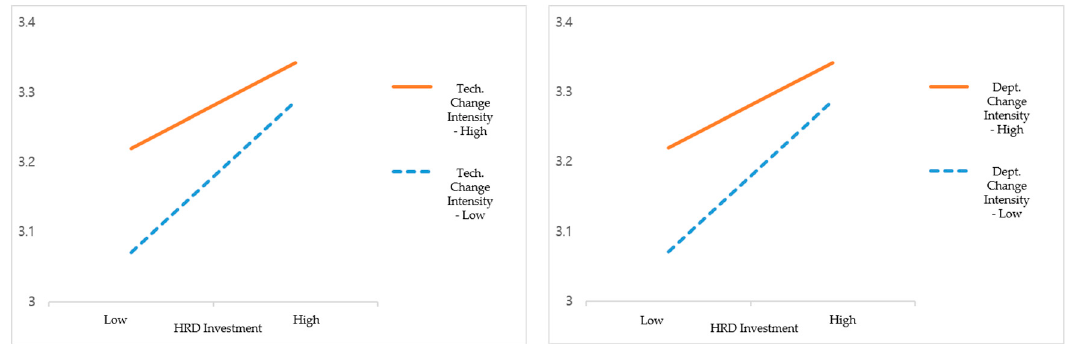
Figure 3. Moderate Effects of the Intensity of Technological (L)/Departmental (R) Changes in Employee HRD Investment: Perceptions of Organizational Innovativeness Relations.